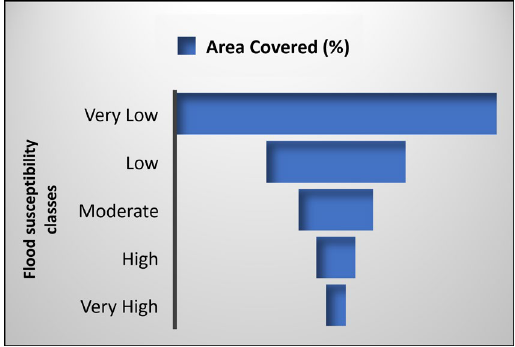
Figure 5: Area covered in percentage